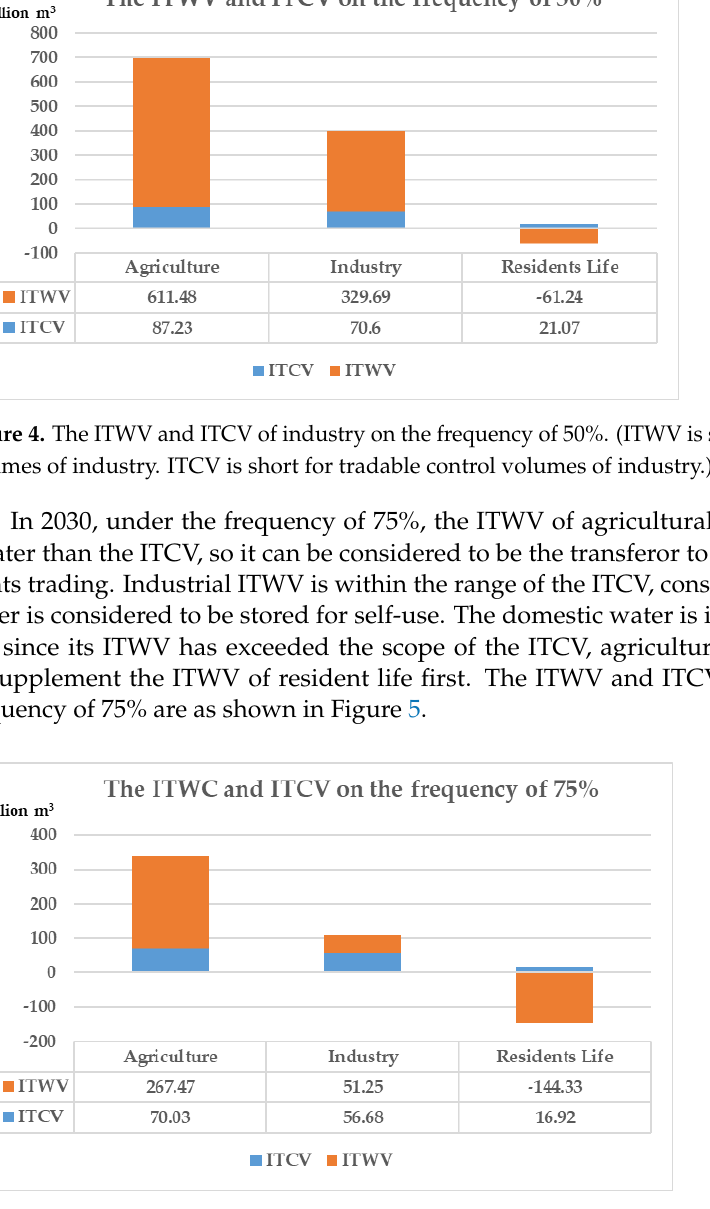
Figure 6. The ITWV and ITCV of industry on the frequency of 90%. (ITWV is short for tradable water volumes of industry. ITCV is short for tradable control volumes of industry.). From the above analyses, water-resource management should combine water-saving with water-rights trading in Changsha city. The contradiction between water shortage and urban development is becoming increasingly acute, water-saving is one of the im- portant ways to realize China ’ s sustainable development. As the capital city of Hunan Province, Changsha city should take the construction of economical society as one of the goals of urban development. At the same time, the city should actively participate in the market mechanisms, improve the secondary allocation of water resources by using water- rights trading, and take water-rights trading as an auxiliary measure to deal with the shortage of water resources. 5.6. Comparison with Other Analyses about the ITWV Compared with the previous qualitative analysis about the TWV [32], the paper pro- posed the quantitative method to calculation the ITWV. The method is based on the theory of property rights, and its premise is to make clear the initial water rights of the region or industry, which reflects the essence of water-rights transaction as an economic activity.